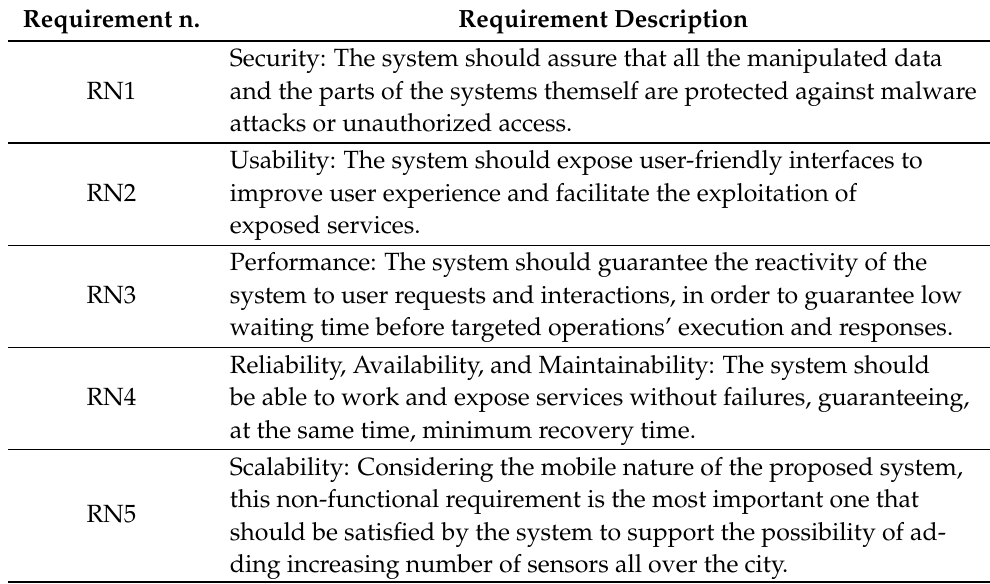
Table 2. Non-Functional requirements. Requirement